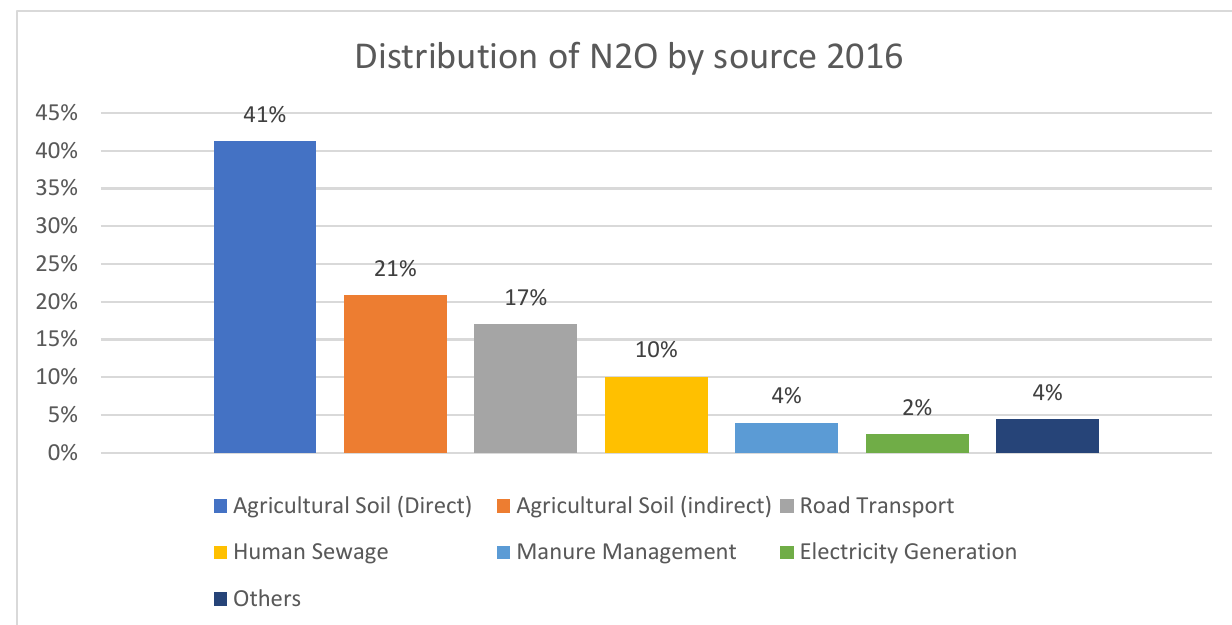
Figure 5. Saudi Arabia’s distribution of N ₂ O emissions by source in 2016 [31].